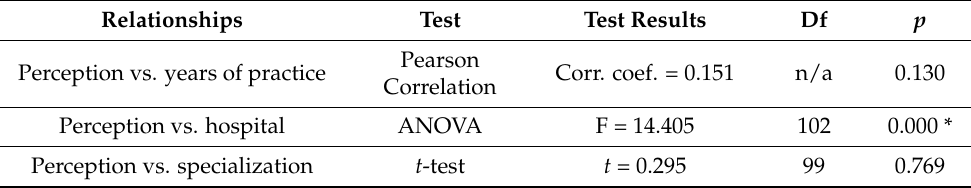
Table 3. Significant relationships among variables. Relationships Test Test Results Df p Pearson Perception vs. years of practice Correlation Perception vs. hospital ANOVA F = 14.405 102 0.000 * Perception vs. specialization t -test t = 0.295 99